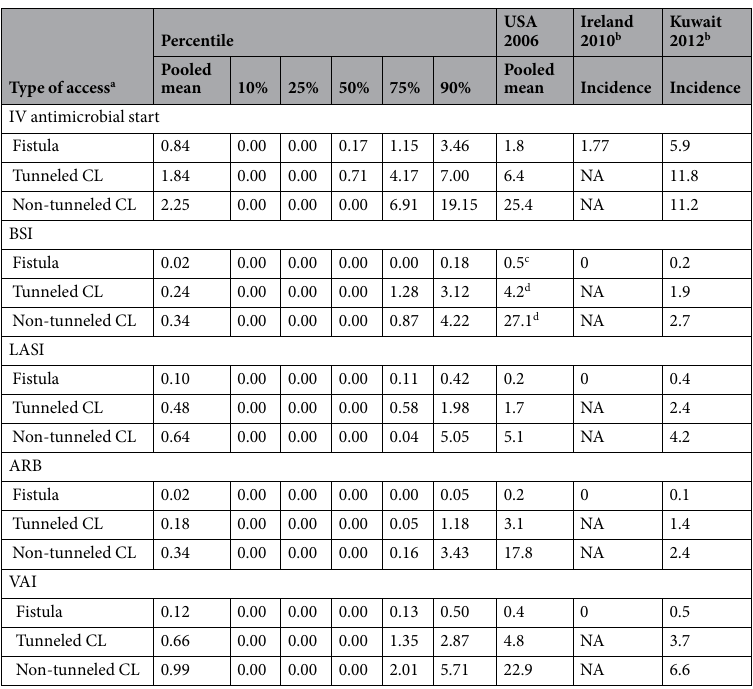
Table 3. Pool mean of the incidence (per 100 patient-months) of dialysis events in participating dialysis units. a The pooled means in the studies of Ireland and Kuwait are not available. NA, not available. b CL, central line. c The 2014 rate of BSI for fistula in USA was 0.26 (https://www.cdc.gov/nhsn/pdfs/dialysis/bsi-rate-vat-de-2014. pdf). d The 2014 rate of BSI for CL (not stratified for tunneled and non-tunneled) in USA was 2.16 (https://www.